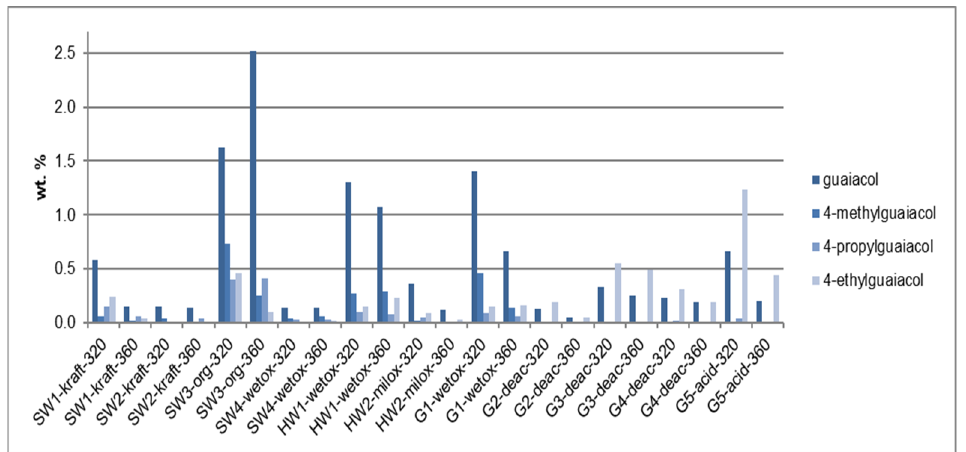
Figure 4. Quantification of guaiacol and selected substituted guaiacols in the produced bio-oils, given as wt.% in the obtained bio-oil. Sample names are specified in the experimental section.